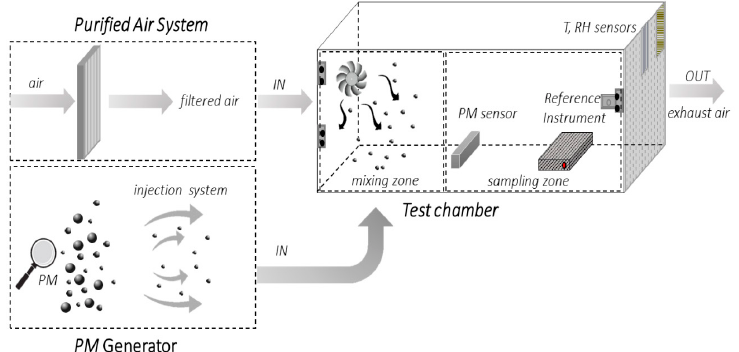
Figure 6. A schematic of the PM characterization system: PM generator, purified air system, and test chamber with PM sensors, Reference Instruments and T, RH sensors.